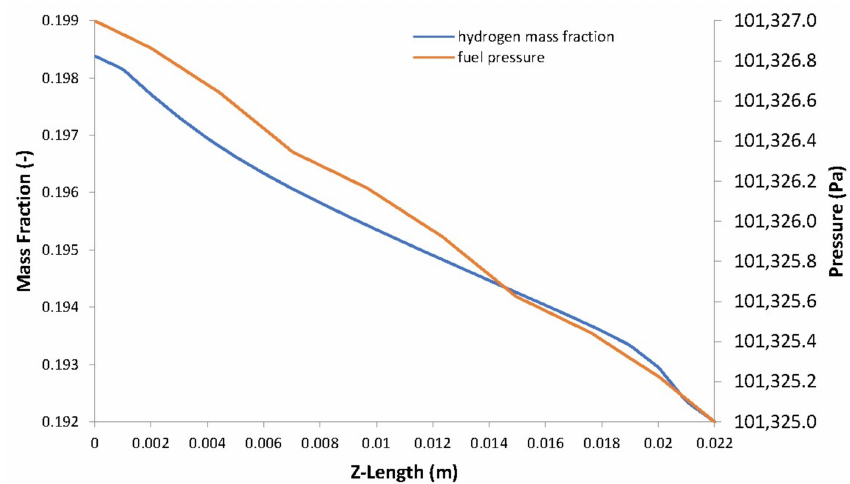
Figure 11. Hydrogen mass fraction vs. fuel pressure.